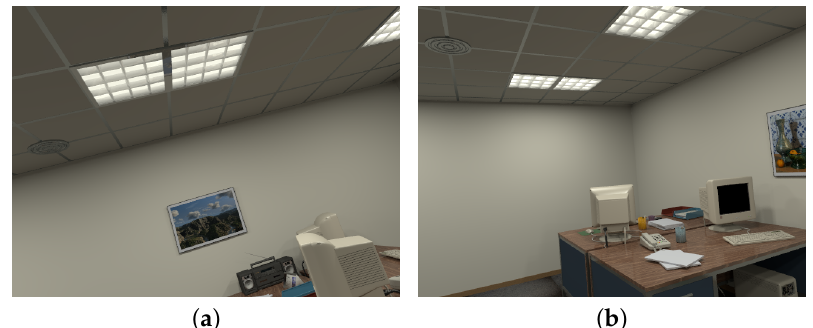
Figure 3. Two mismatched loop images based on the appearance constraint: ( a ) Color image of Frame 182 in the ‘OfficeRoom1’ sequence of the ICL-NUIM dataset. ( b ) Color image of Frame 319 in